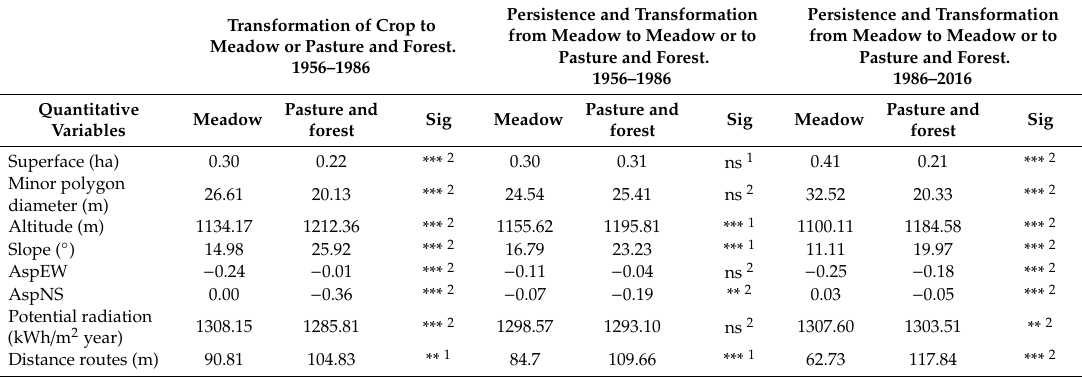
Table 3. Characteristics and comparison of the parcels that have been transformed into a meadow or pasture and forest in the di ff erent scenarios. Quantitative variables expressed in mean. Transformation of Crop to Meadow or Pasture and Forest.